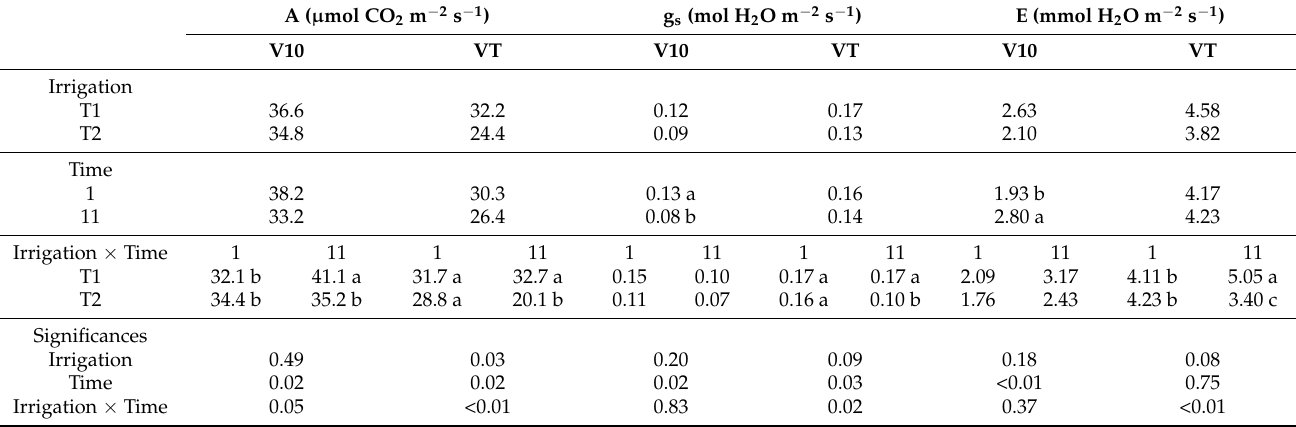
Table 1. Effects of the control (T1) and drought stress (T2) treatments on net assimilation (A), stomatal conductance (g s ), and leaf transpiration (E) at the beginning and the end of the trial (days 1 and 11 after last irrigation) for the lluteño maize, during vegetative growth (V10) and flowering (VT) phenological